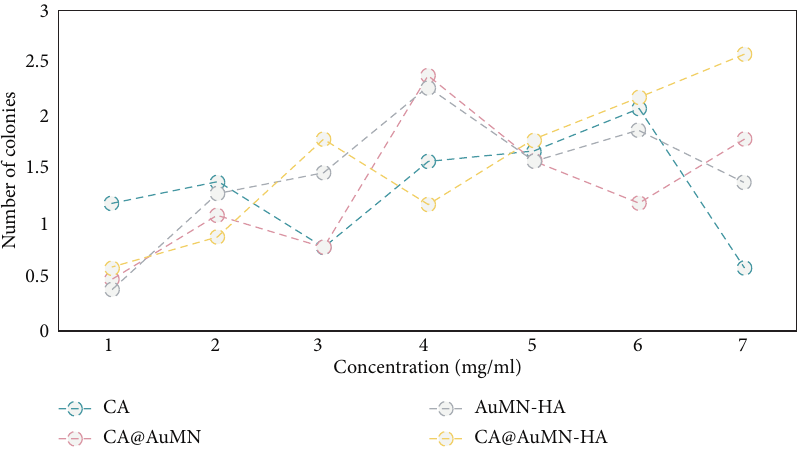
Figure 2: Results of plate colony